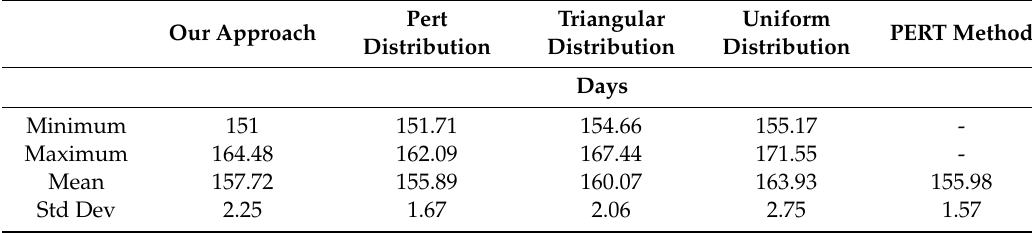
Table 8. Summary statistics for the results of the analysis.